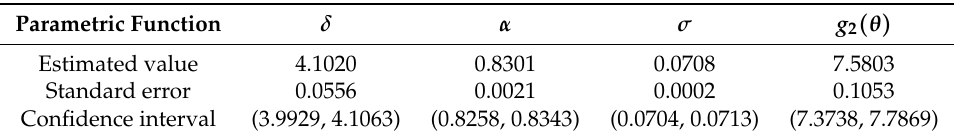
Table 2. Estimated values, standard errors and 95% confidence intervals of the parameters and the inflection